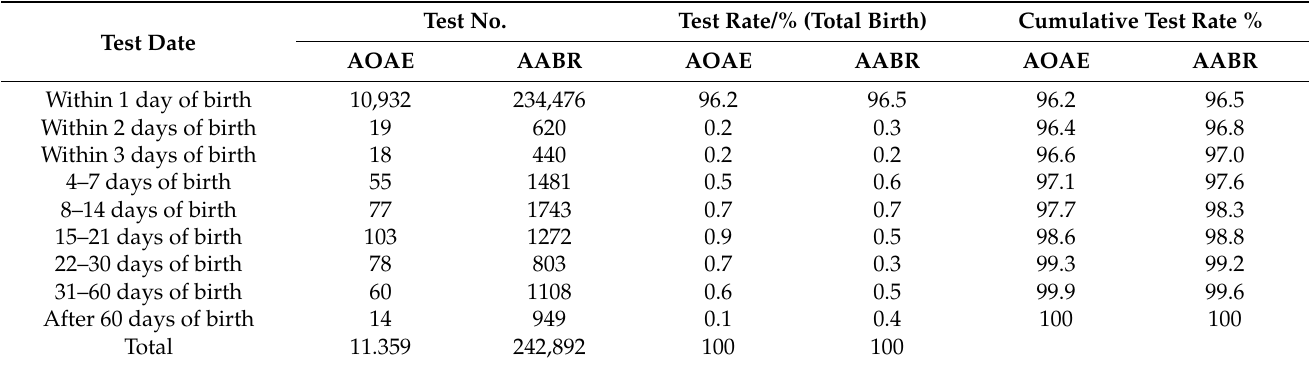
Table 3. Test date (infant age) of the 1st newborn hearing screening in 2020.